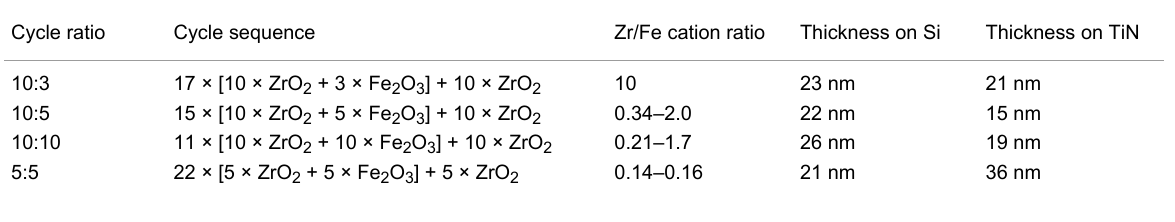
Table 1: List of the ZrO 2 /Fe 2 O 3 films, with constituent oxide cycle ratios and full growth cycle sequences indicated, deposited on Si substrates (sub- jected to magnetometry) and TiN substrates (subjected to electrical measurements). The range of cation ratios is due to the variation of the ratios measured at different locations on the substrate holder and are due to the film thickness growth rate profiles along the gas flow direction. In these ex- periments, lower cation ratios were measured on TiN substrates as compared to Si substrates. Cycle ratio Cycle sequence Zr/Fe cation